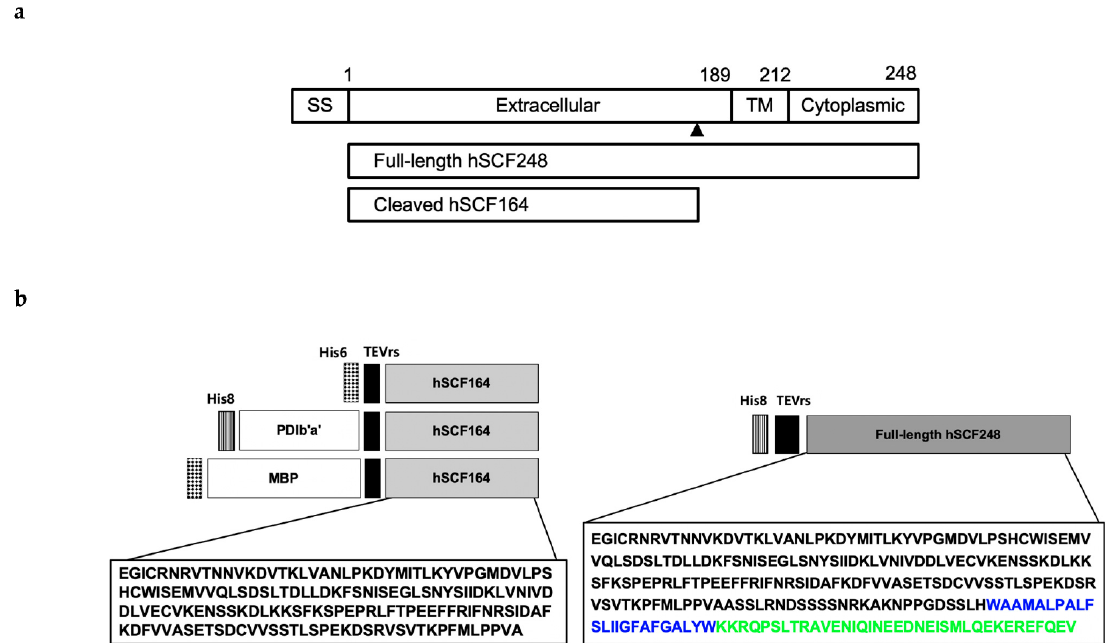
Figure 1. Design of hSCF164 and hSCF248 constructs. ( a ) Structure of His-hSCF248 and hSCF164. The arrow indicates the proteolytic cleavage site. SS, signal sequence; TM, transmembrane. ( b ) Schematic structure of the His-hSCF248, His-hSCF164, hSCF164, PDIb’a’-hSCF164, and MBP-hSCF164 constructs. The amino-acid sequence in black is the extracellular region, the blue sequence is the membrane penetration region, and the green sequence is the cytoplasmic region. MBP, maltose-binding protein; PDIb’a’, b’a’ domain of protein disulfide isomerase; TEVrs, tobacco etch virus protease restriction site; His6, six histidines; His8, eight histidines.